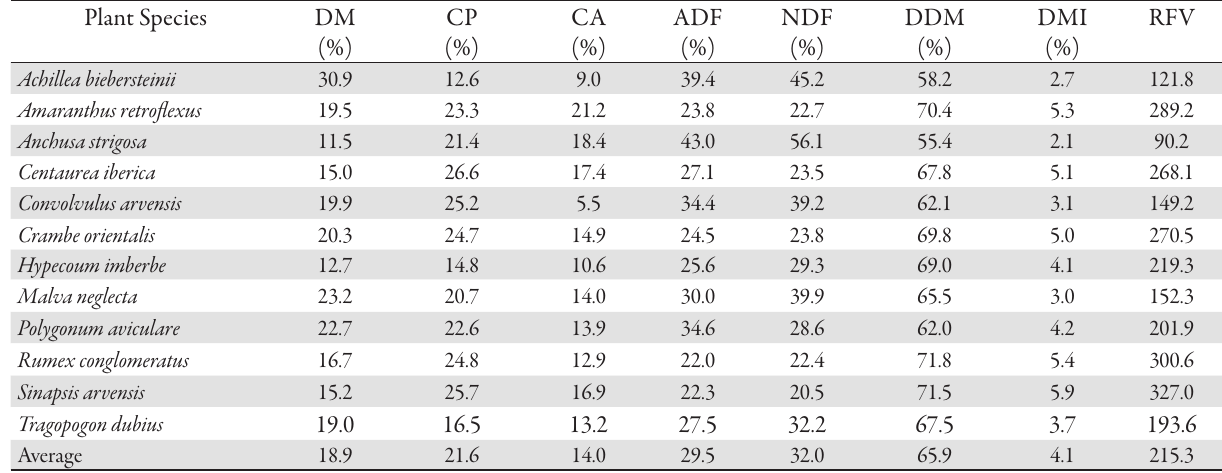
Tab. 2. Average Crude Protein (CP), Crude Ash (CA), Acid Detergent Fiber (ADF), Neutral Detergent Fiber (NDF),